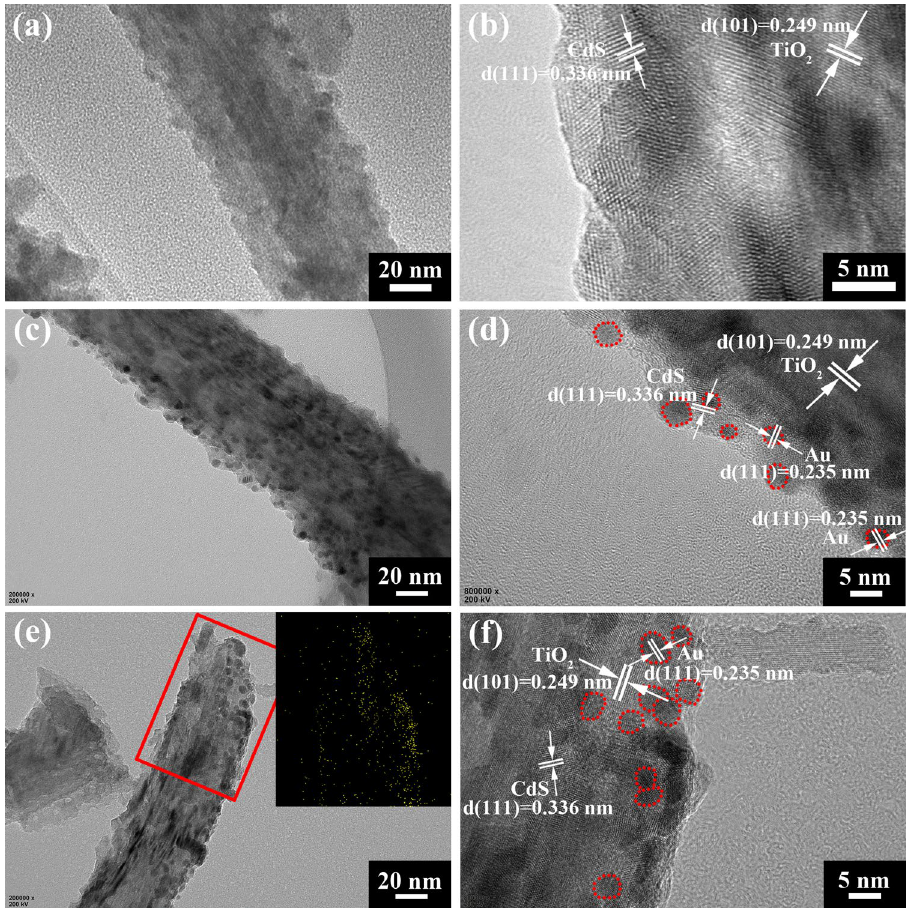
Figure 3. TEM images of TiO 2 NRAs/CdS/Au: ( a and b ) 0 s, ( c and d ) 30 s, ( e and f ) 60 s. The inset of ( e ) is the distribution of Au NPs corresponding to the region marked by the red rectangle. Au NPs are marked by red circles in ( d and f ).